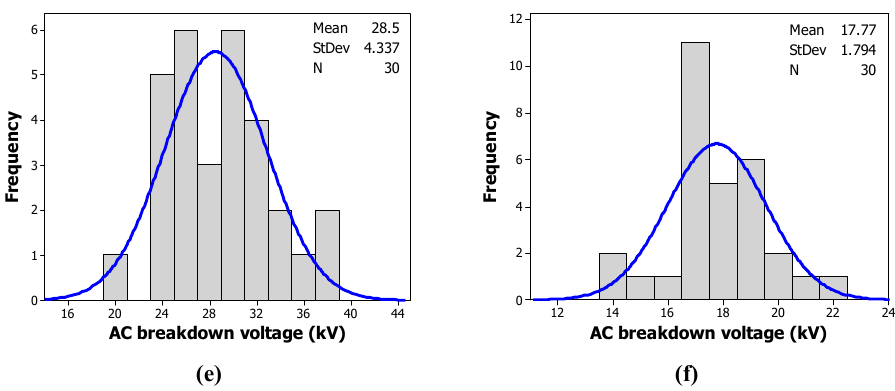
Figure 8. Frequency of the breakdown voltage of: ( a ) the MO; ( b ) the MO/CCl 4 (200 ppm); ( c ) the MO/CCl 4 (300 ppm); ( d ) the MO/CCl 4 (400 ppm); ( e ) the MO/CCl 4 (500 ppm); ( f ) the MO/CCl 4 (600 ppm).